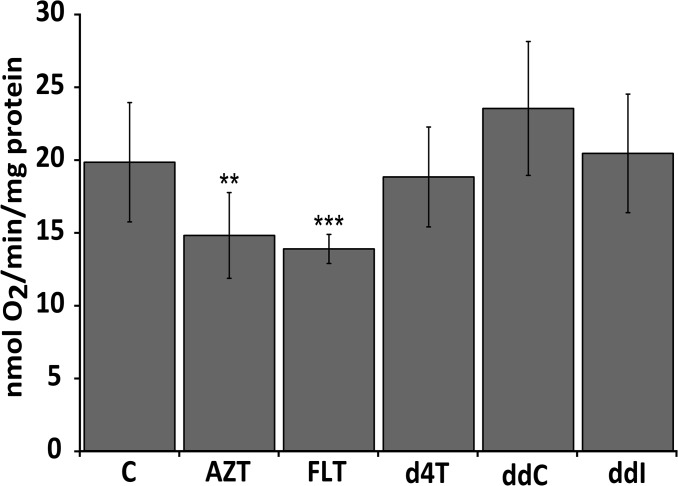
Oxygen consumption rates in NRTI exposed worms.Drug concentration was 100μM in all experiments. FLT and AZT exposed worms show a significantly reduced oxygen consumption rate compared to unexposed animals. C = Control, ** p-value <0.01, *** p-value <0.001. Significance was determined using a two tailed student’s t-test assuming unequal variance.